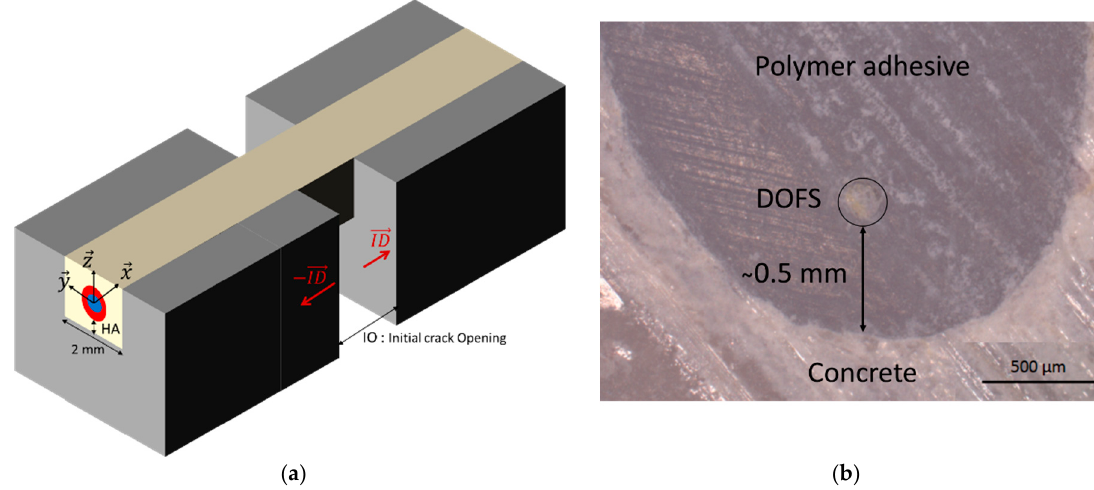
Figure 15. ( a ) Simplified model for the numerical approach of the crack opening; ( b ) actual cross section of an instrumented specimen showing a DOFS sealed in a groove (optical